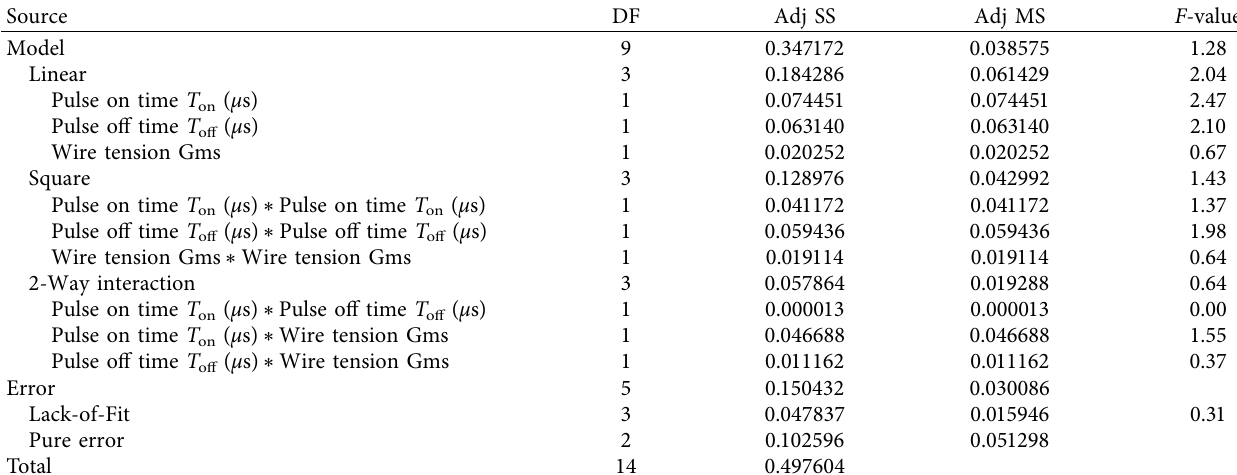
Table 4: Analysis of variance-Ra.